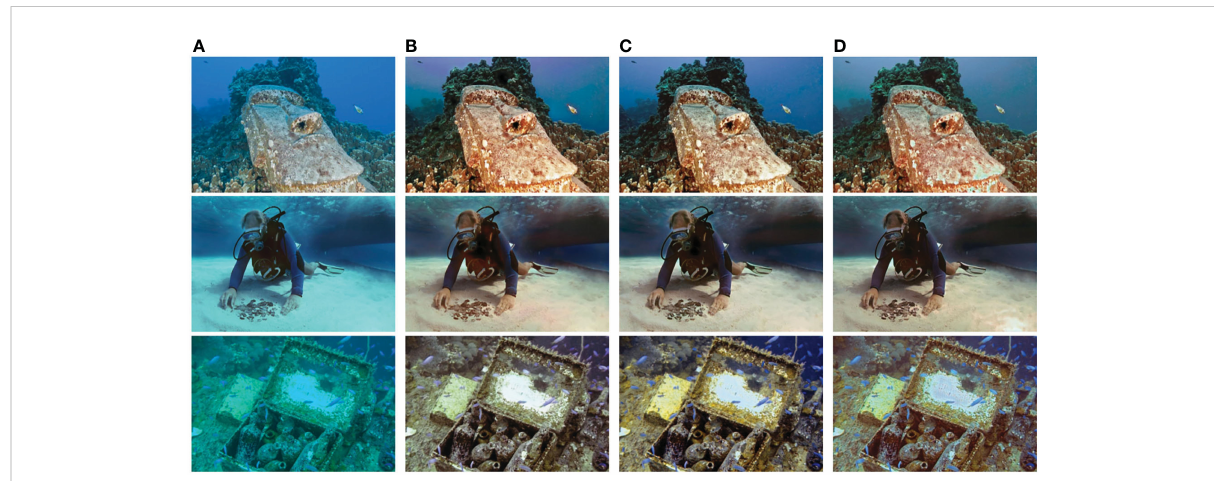
FIGURE 13 Visual comparisons with different RCAB numbers N in the generator on the UIEB dataset. From left to right, (A) shows the raw underwater images, and (B – D) are the results of N = 3, N = 4(Ours) and N = 5, respectively.